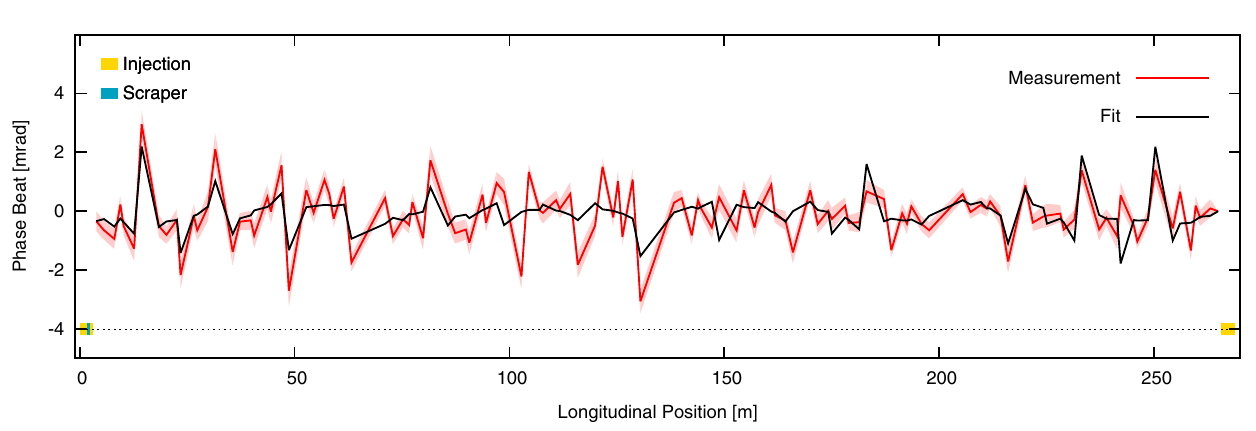
FIG. 7. Measured phase beat for each BPM along with the one computed from the nominal machine model including the two measured defocusing kick produced by the beam pipe and the injection